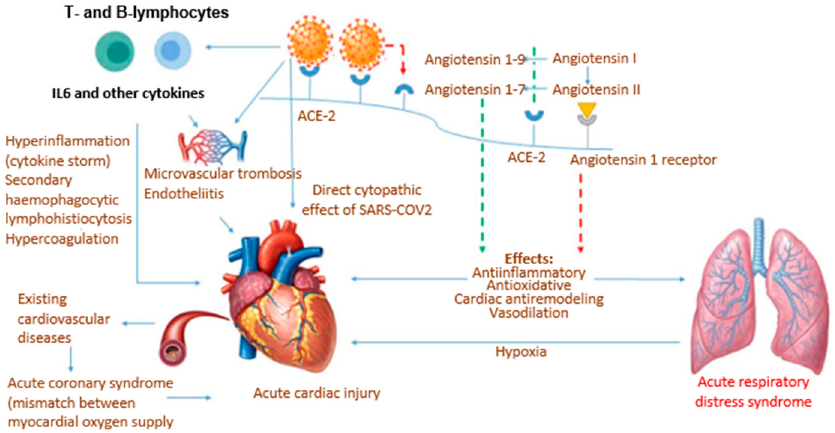
Figure 1. The relationship between potential mechanisms of acute cardiac injury in COVID-19 with the focus on pro-inflammatory autacoids.